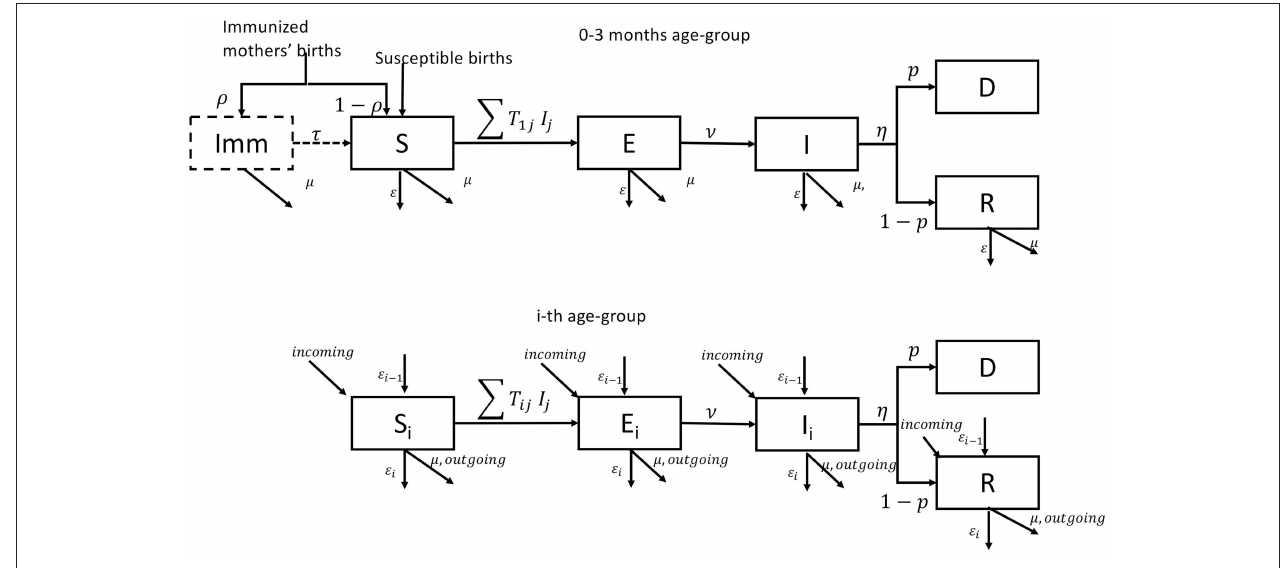
FIGURE 2 | Pictorial representation of the epidemiological model for the first and i-th age group.